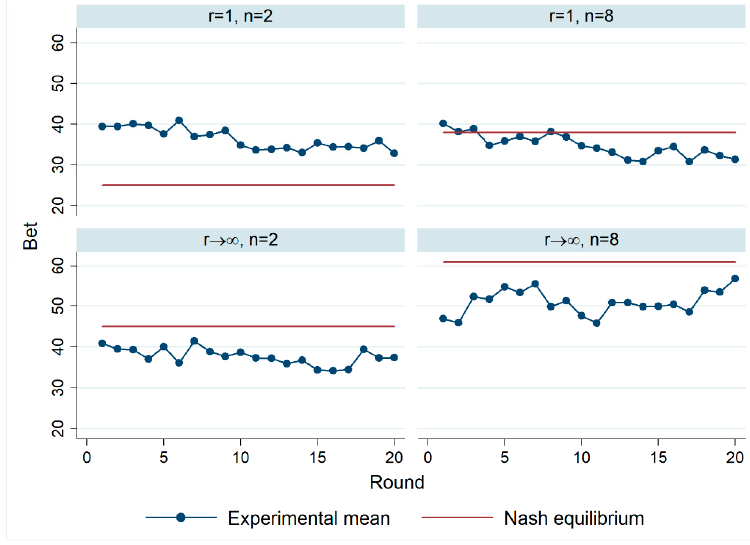
Figure 1. Development of average bets over the rounds.